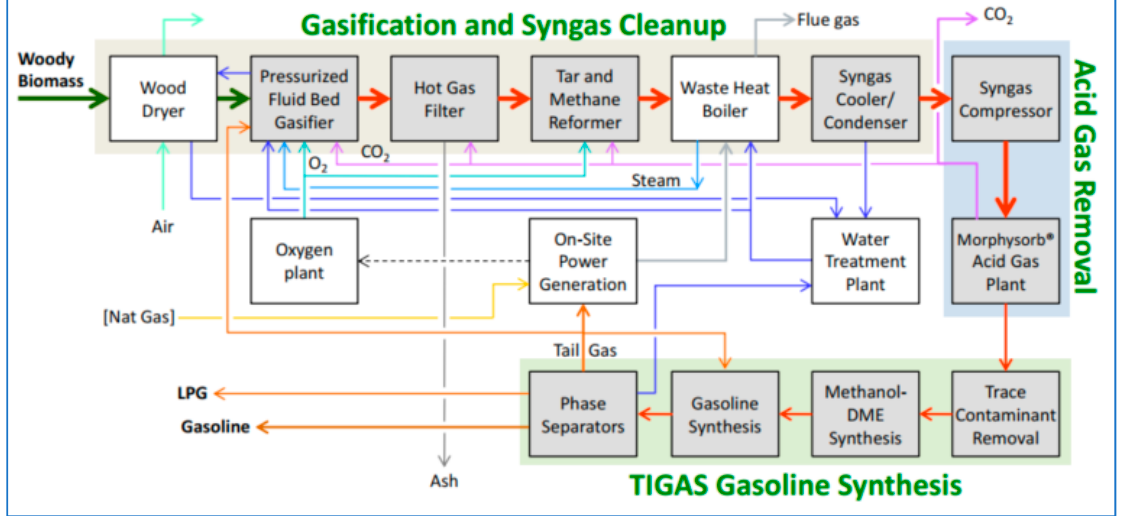
Figure 9. Schematic flow ‐ sheet of the wood ‐ to ‐ gasoline/LPG demo plant ‘green gasoline from wood’.